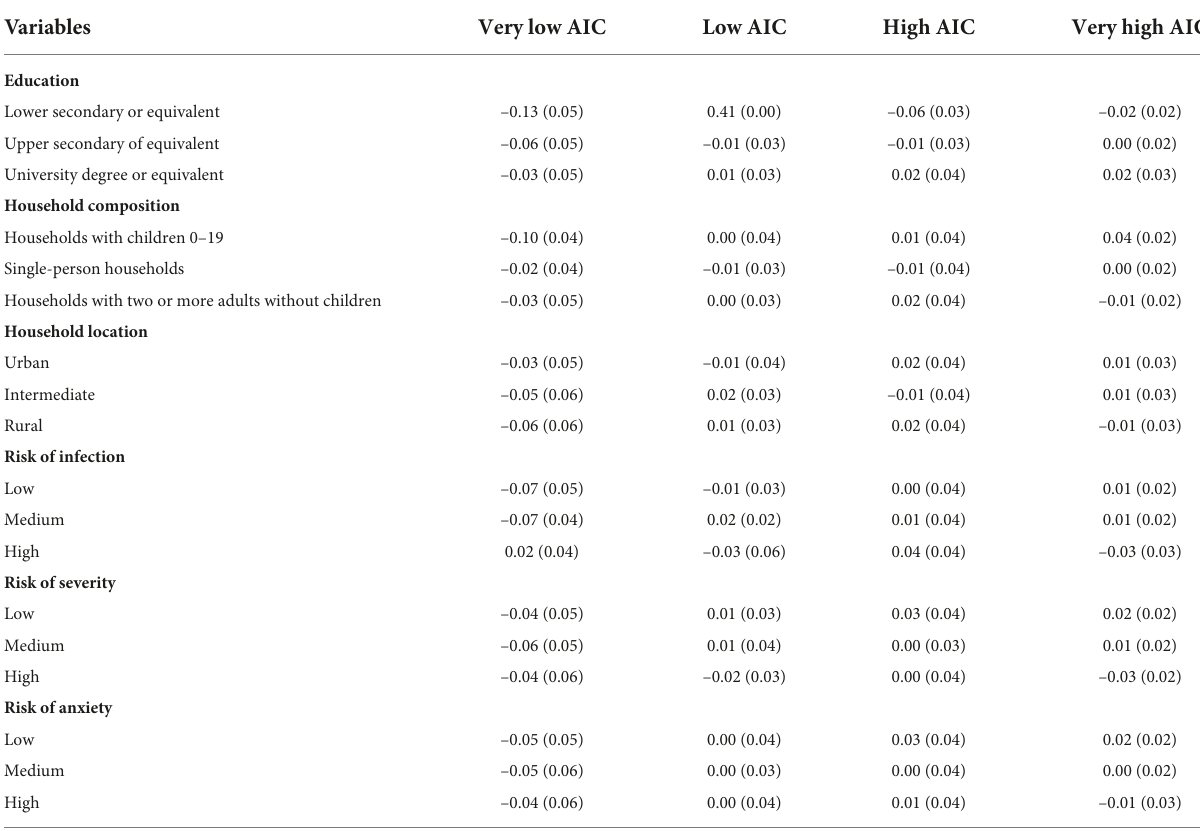
TABLE 8 Model post-estimates means ( SD ) for different AIC and individual household level effects describing the change in consumption of food during the COVID-19